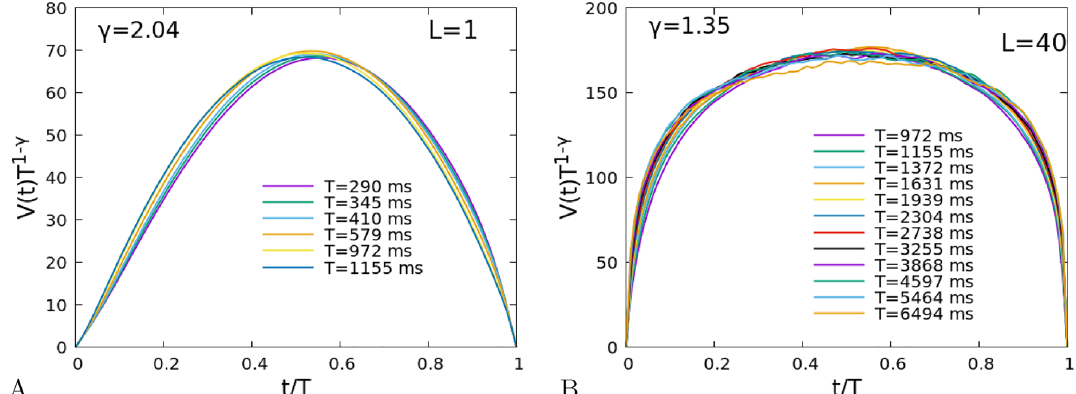
T / 1.09, 1.09 T centered on the [ ] 40 =